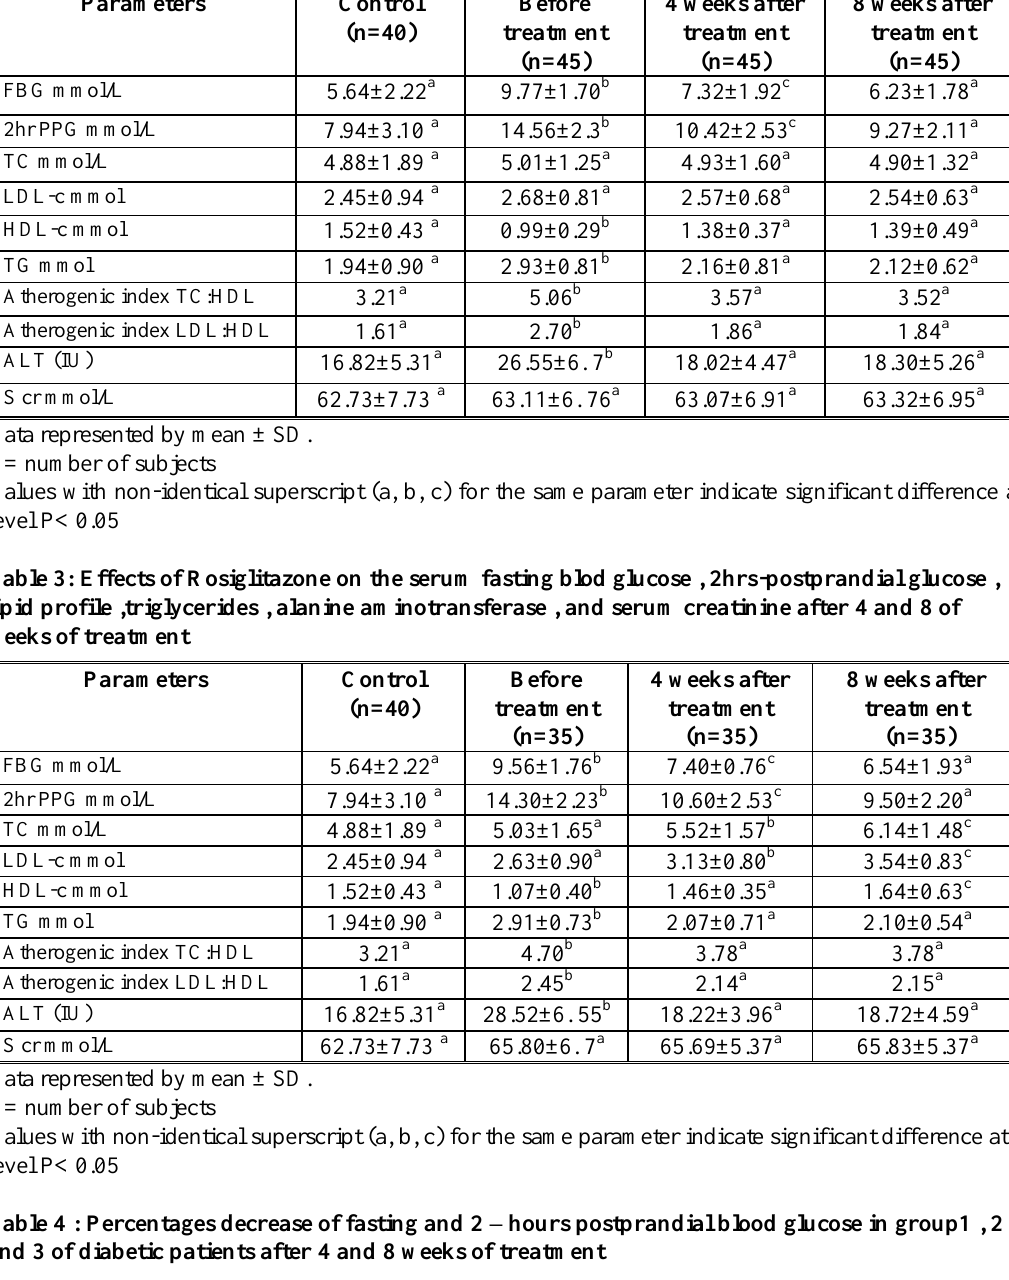
Table 2: Effects of Glibenclamideon the serum fasting blod glucose , 2hrs-postprandial glucose , lipid profile ,alanine aminotransferase , and serum creatinine after 4 and 8 of weeks of treatement .